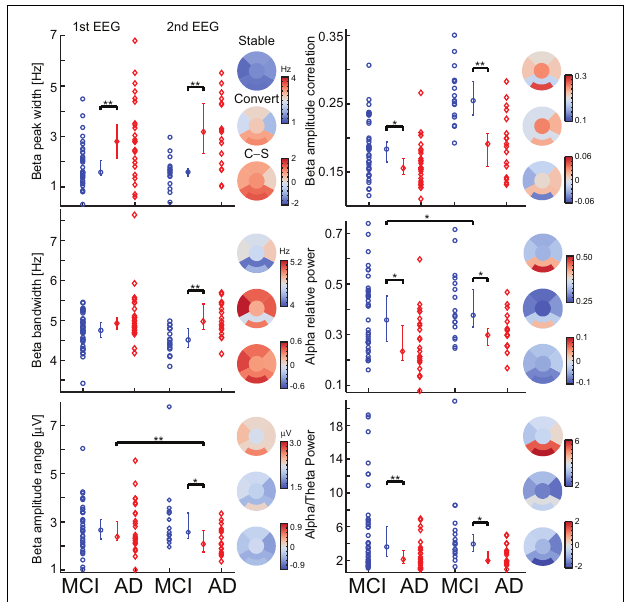
FIGURE 4 | Most biomarkers in the diagnostic index have differences between the MCI-stable (MCI) and AD-converter (AD) groups, and only two have longitudinal changes. For each biomarker, a separation plot is shown for 1st EEG and 2nd EEG. The values are median across channels with significant differences between the MCI-stable (MCI) and AD-converter (AD) groups (Binomial corrected). Topographical plots are of 2nd EEG median value across subjects and channels in 6 regions; Frontal, left/right temporal, Central, Parietal, and Occipital. Asterisk indicates significant differences (permutation test on median, binomial corrected, ∗ p < 0 . 05, ∗∗ p < 0 .